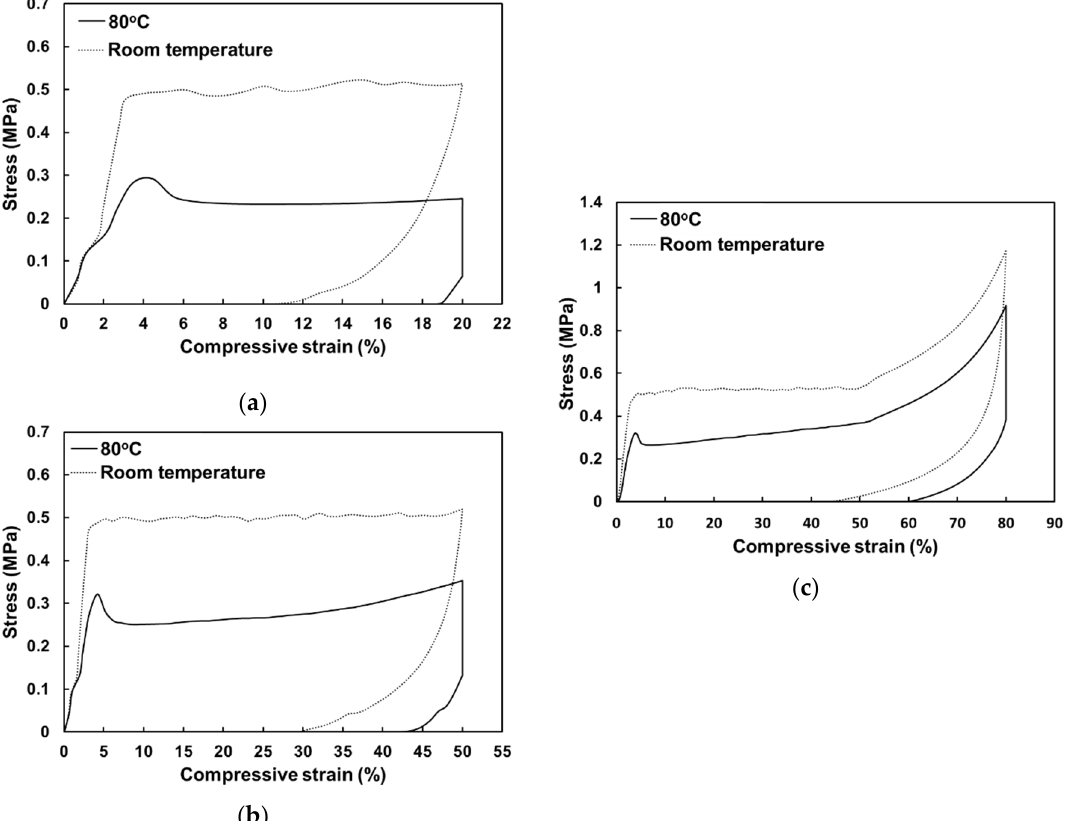
Figure 5. Typical stress vs. strain relationships in uniaxial compression to a maximum strain of 20% ( a ), 50% ( b ), and 80% ( c ) at room temperature and 80 ◦ C (followed by cooling back to room temperature) and then unloading.